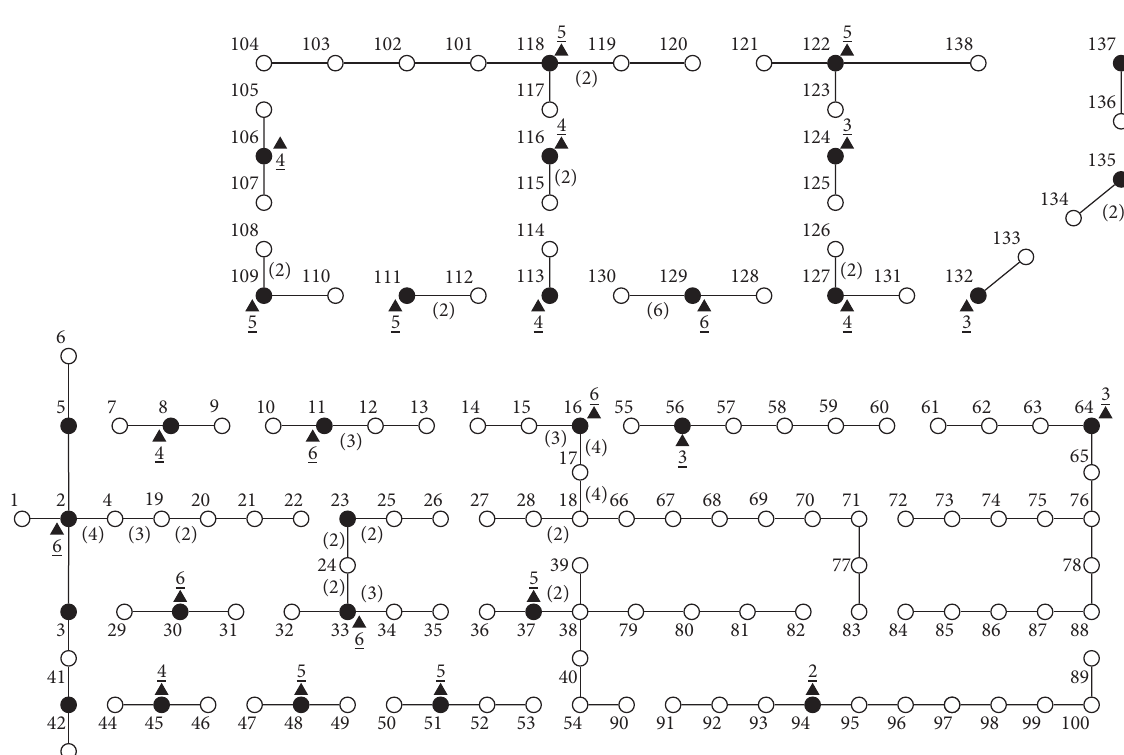
Figure 7: Case B: primary network.